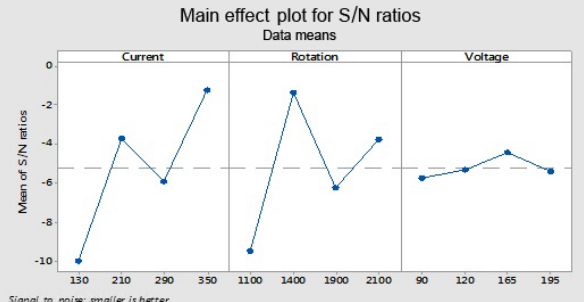
Figure 16. Current and voltage relation of OC 1 for the cryogenic